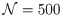
Cell colonies in a square grid under complex illumination in the vector integration case.Configurations of a number of cell colonies, arranged in a square grid, illuminated by two different light sources placed at N and E. This arrangement of light sources creates a gradient in intensity. Cells bias their motion towards the vector sum of the two light sources. (a) shows the effective total intensity of the light sources in the direction of the vector sum (pvec) is represented across a 5 × 5 grid. The direction of the vector sum of the light sources at each of the grid points is shown in (b) The morphology of colonies placed on this 5 × 5 grid is shown in (c). Each colony contains N=500 cells, and the model was simulated for 4 × 104 time steps.